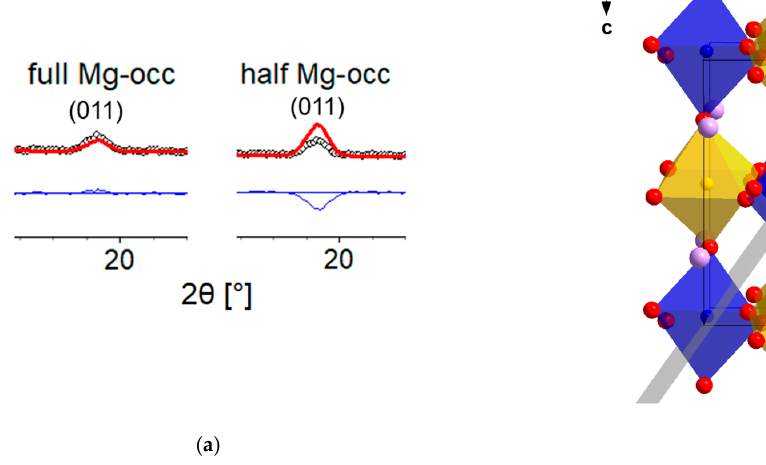
Figure 1. Mg occupancy of LAMT: ( a ) Discrepancy of the (011)-Bragg peak intensity on the NPD data between the full and half Mg occupancy; ( b ) (011)-plane in the monoclinic unit cell. Isotropic displacement parameters are visualized at the 50% probability level.